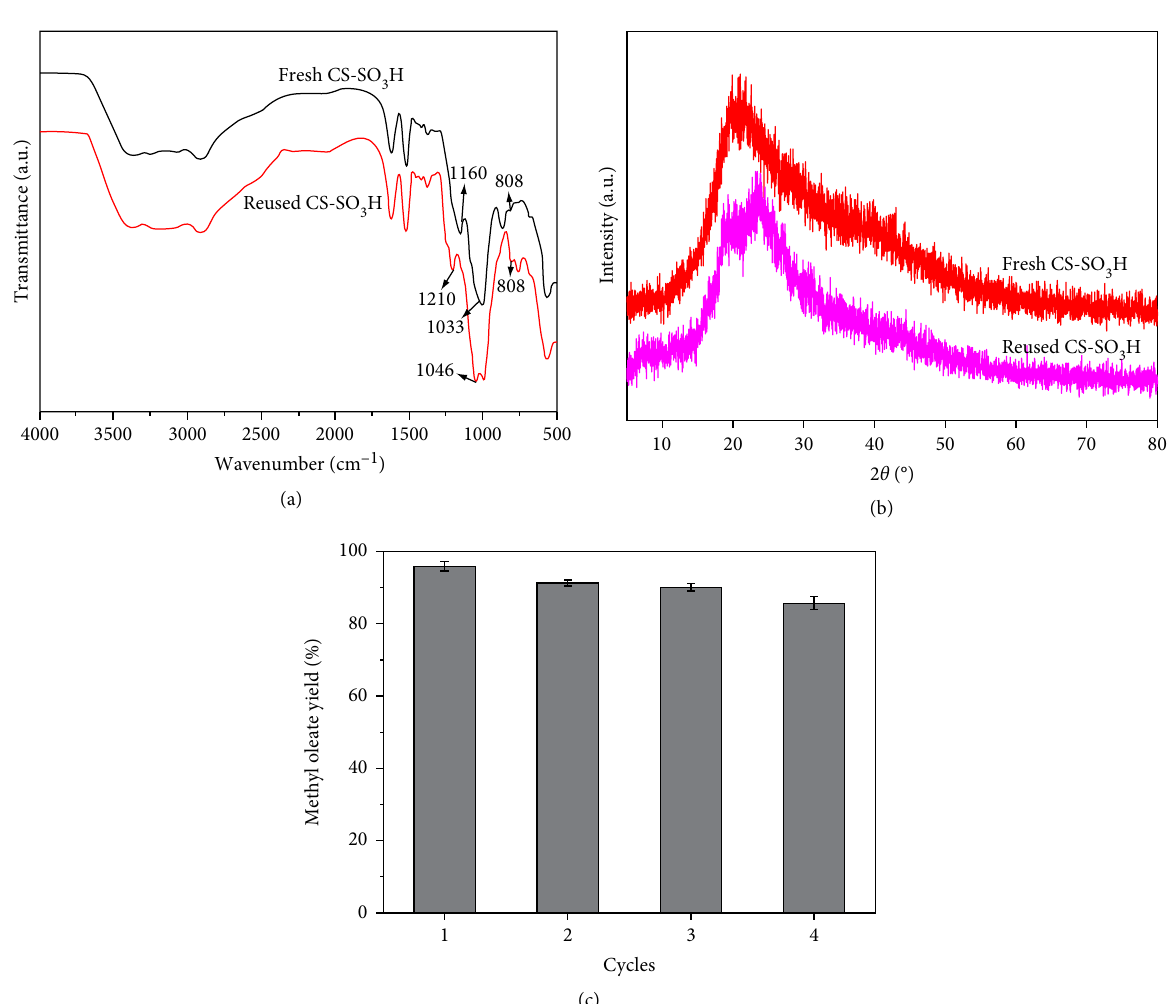
H catalyst. Reaction conditions: reaction temperature 3